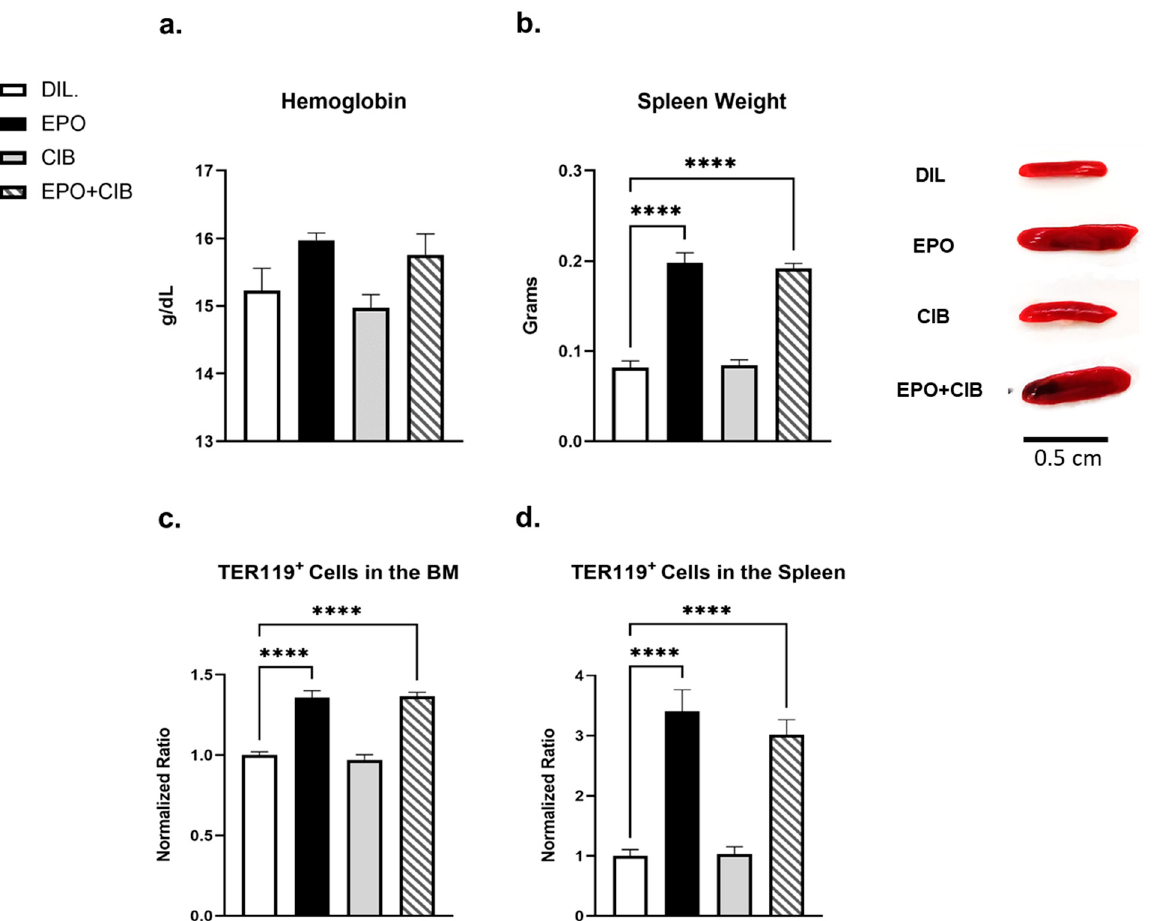
Figure 8. Cibinetide (CIB) does not interfere with the erythropoietic response to Erythropoietin. ( a ) Hemoglobin levels. ( b ) Average weights of the spleens with respective representative photographs from untreated, EPO, Cibinetide, EPO + Cibinetide-treated mice. ( c , d ) Flow cytometry analysis of TER119 + erythroid progenitors in the bone marrow ( c ) and in the spleen ( d ). Values on the Y axis represent the normalized ratio of the Ter119 + cells in each treatment group relative to the diluent control. Values are mean ± SEM. N = 7 mice in each group. **** p <0.0001.